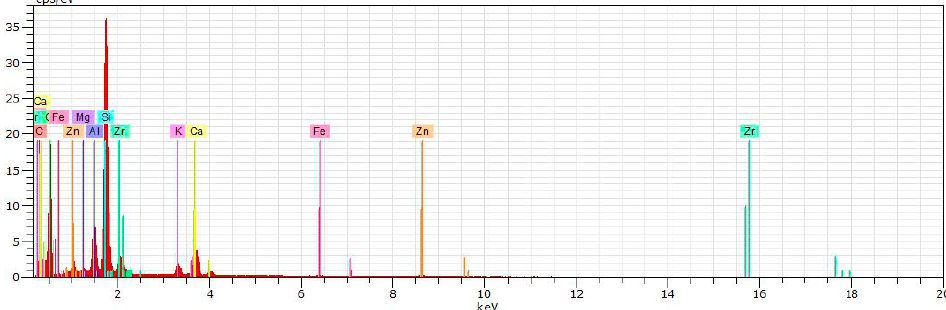
9 of 21 Figure 8. SEM microscope applying 150 magnifications of a tile Section. Porcelain stoneware and glazed substrate. Figure 9. SEM applying 350 magnifications of the ZrO 2 glaze. Homogeneous distribution of Zr and Zn.